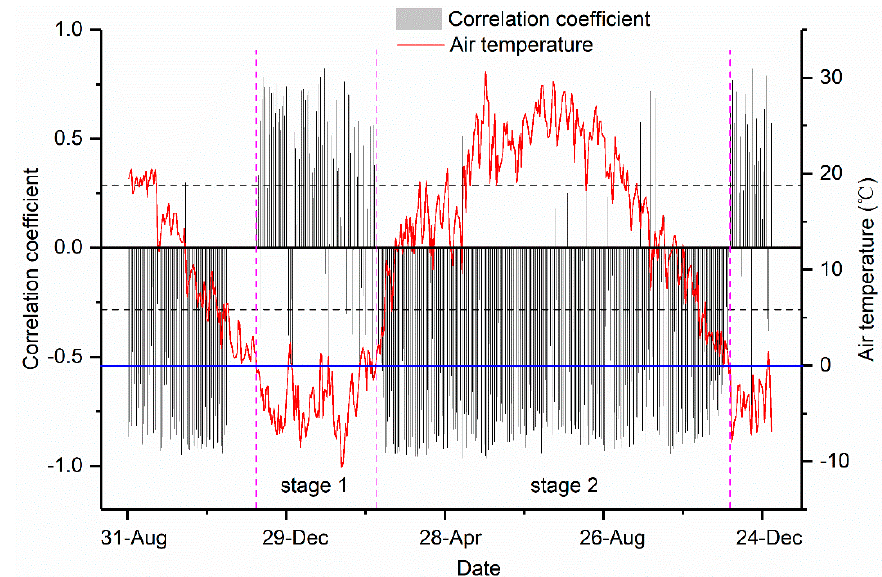
Figure 3. Pearson correlation coefficients between diurnal stem cycles and within-day air temperatures. Vertical dashed line corresponds to stage partition times of 24 March and 30 November. Horizontal dotted lines indicate p = 0.05 statistical significance threshold values.